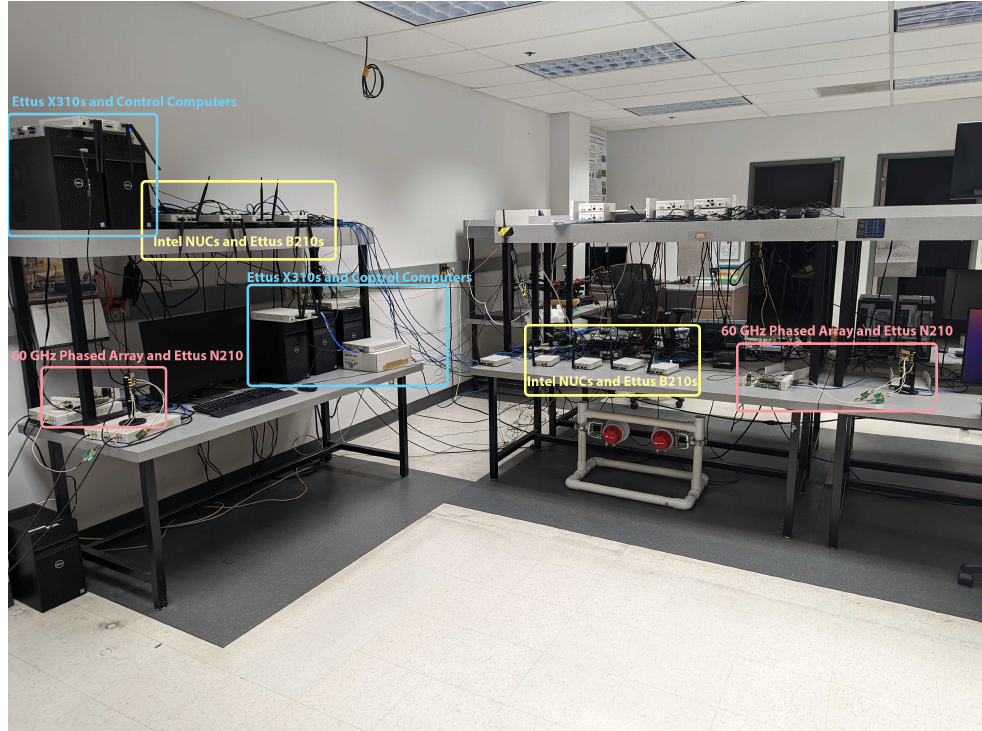
Figure 2. Example deployment of the WISCANet control architecture on several Ettus USRP devices controlled by Dell workstations and Intel NUC Small Form Factor PCs (SFFPCs). This deployment features 8 Ettus B210s and 5 Ettus X310s which operate in the typical sub-6 frequency bands. This implementation also features (2) 60 GHz phased array antennas for mmWave experiments. This deployment can be used for a variety of experiments in both mmWave and sub-6 GHz bands, enabling diverse, multi-band, multi-antenna experiments but also remaining accessible to users without advanced networking and programming